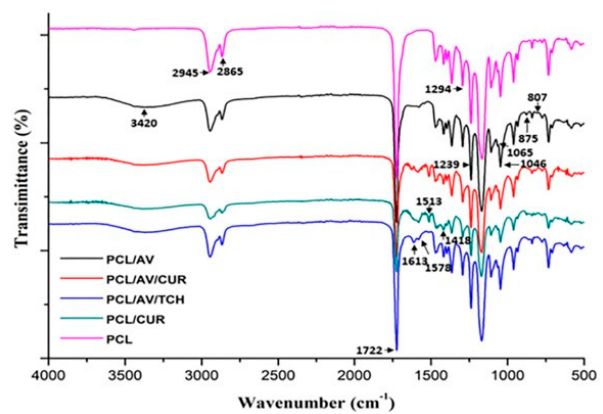
Figure 2. FTIR spectra of biocomposite nanofibrous scaffolds of PCL, PCL/AV, PCL/CUR, PCL/AV/CUR and PCL/AV/TCH.